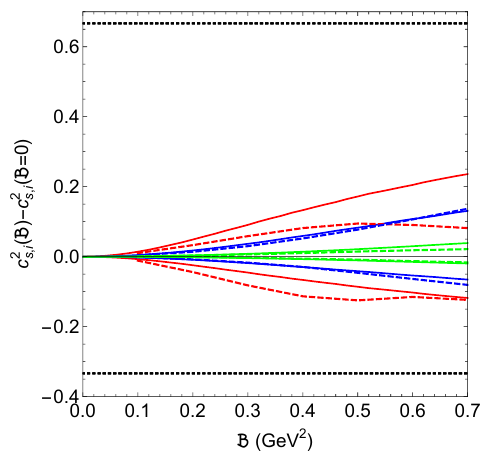
Figure 12 . Squared speeds of sound (solid lines) c 2 as functions of B , with their values at B = 0 s,i subtracted„ compared to a numerical estimate obtained from lattice QCD results (dashed lines) for fixed values of the temperature. For simplicity, we omitted the error bars in the numerical estimate. The lines above zero correspond to the longitudinal direction i = z whereas the lines below zero correspond to the transverse direction i = x . The dotted upper and lower lines correspond to the values 2 / 3 and − 1 / 3 respectively, expected in the limit B → ∞ . The red, blue and green colours correspond to T = 0 . 15 GeV, T = 0 . 2 GeV and T = 0 . 3 GeV